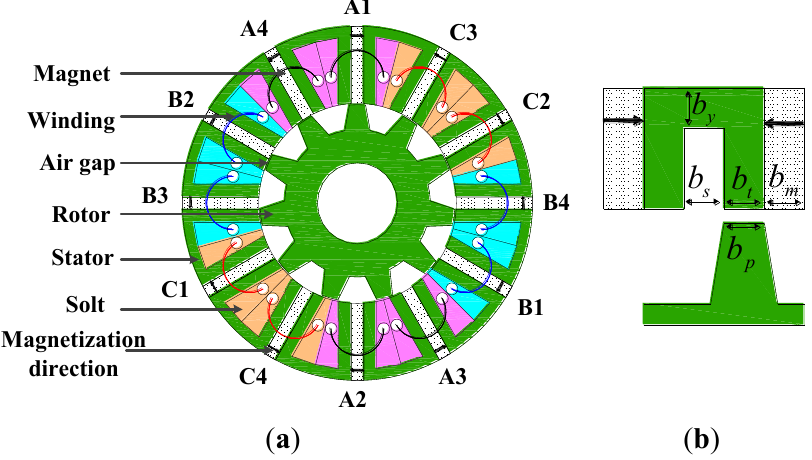
Figure 1. Schematic of the proposed flux switching permanent magnet (FSPM) machine: ( a ) all poles wound cross section; and ( b ) one